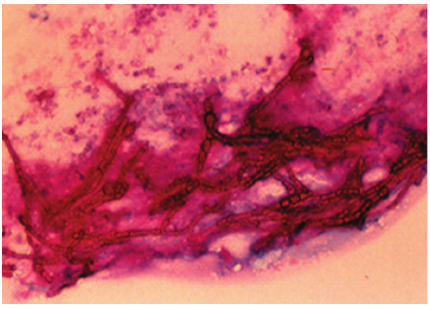
Figure 6: Pas stain of septate hyphae in corneal sample smears × 400.